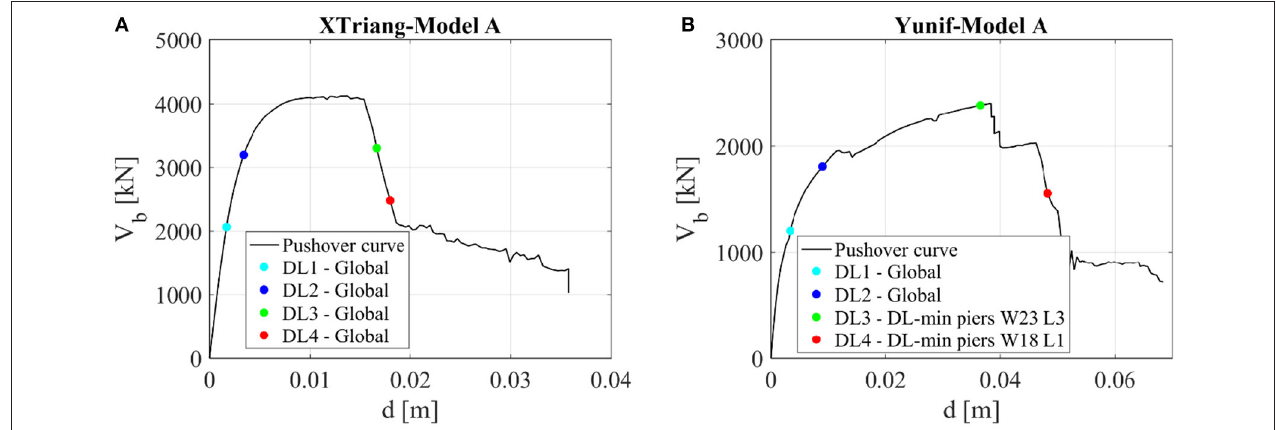
FIGURE 10 | Example of the final position of DLi in the pushover curve in the X (A) and Y (B) directions (W23L3 stands for wall 23 in the 3rd floor and W18L1 for wall 18 1st floor–see Figure 8A